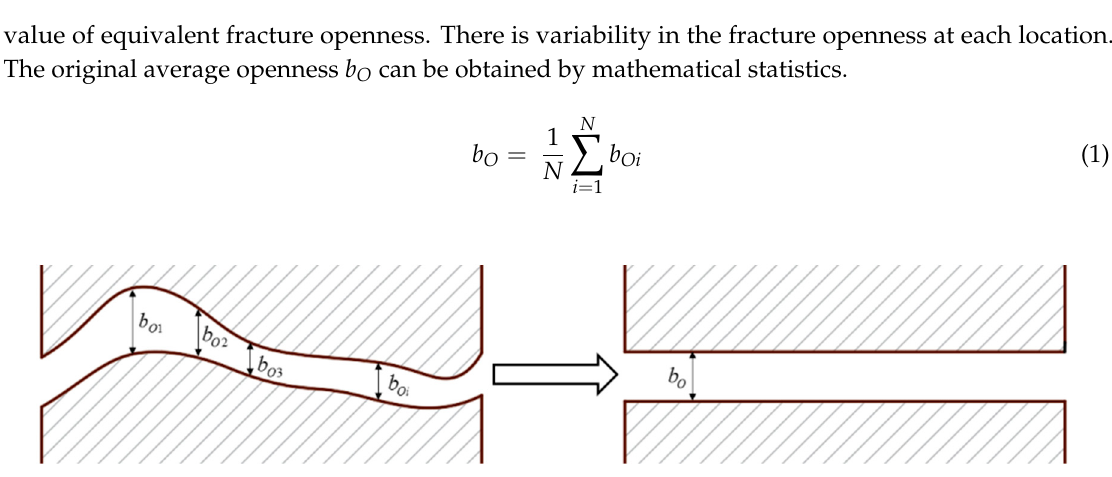
Figure 2. Calculation diagram of the Bingham fluid diffusion in a two-dimensional parallel fracture.